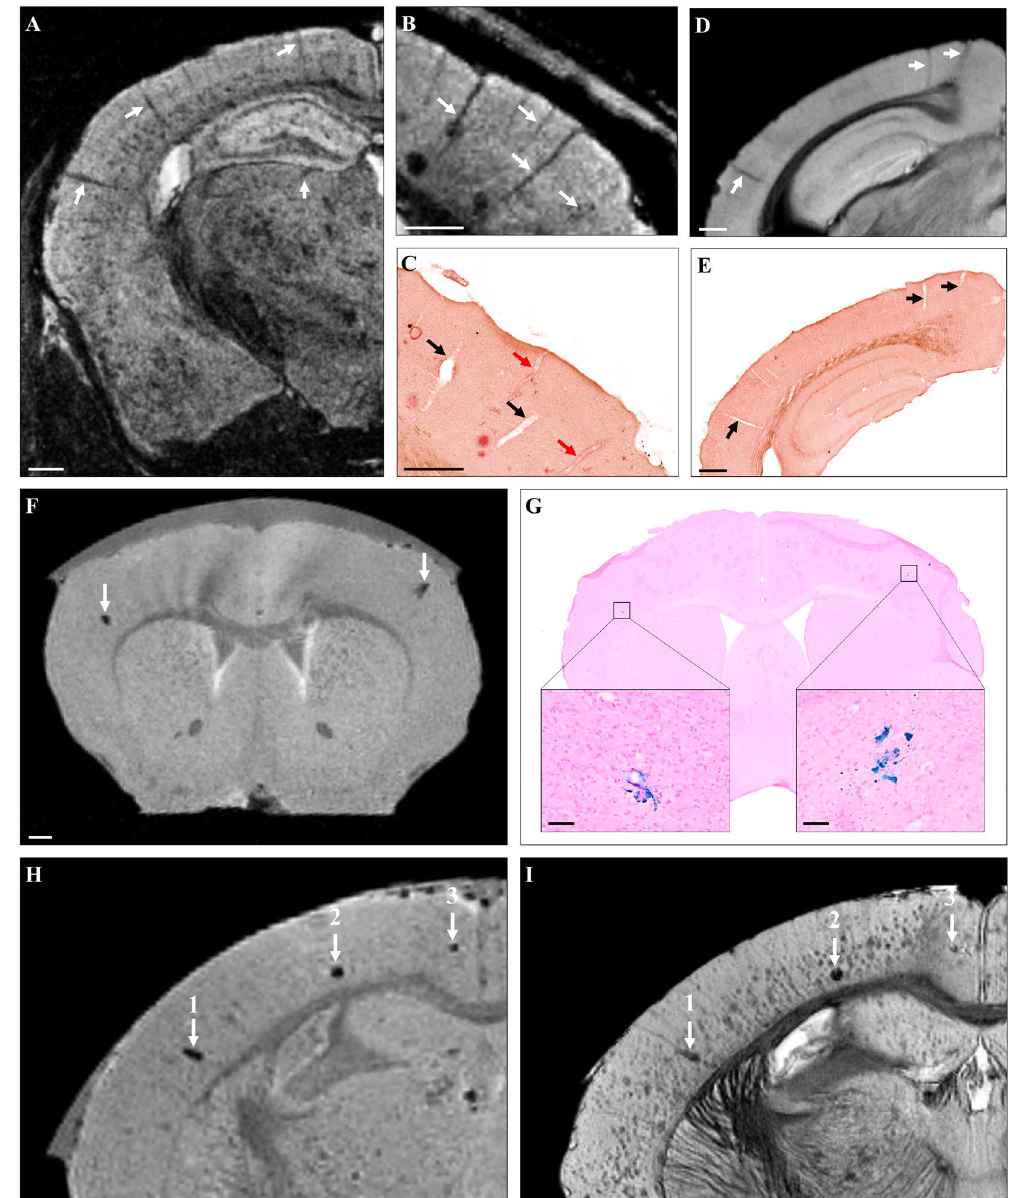
Figure 7. Visualization of CAA and cerebral microhemorrhages by Gd-stained MRI. Linear hypointense elements corresponding to blood vessels were detected on MR images of mouse models of amyloidosis ( A–C , arrows). Registration between MR images ( B ) and histological sections ( C ) showed that some blood vessels seen on MRI were matched with CAA-positive vessels (red arrows) while some others were matched with CAA-negative vessels (black arrows). MR images of C57Bl/6 amyloid-free mice showed similar hypointensities ( D , arrows) that were matched with blood vessels ( E , arrows) confirming that CAA was not responsible of the hypointense nature of blood vessels by Gd-stained MRI. Sparse focal signal attenuations were observed on MR images before Gd-staining ( F ). They could be registered with microhemorrhages on Perls’ stained histological sections ( G , boxes). Microhemorrhages easily seen on MRI before Gd-staining ( H , arrows) could be matched with some hypointense spots on Gd-stained MRI (I, arrows). Large microhemorrhages (1, 2) were easily distinguished from amyloid plaques on MR images but small microbleeds (3) and amyloid plaques were similar in appearance. Scale bars: 500 µ m ( A–F , H , I ) and 100 µ m ( G